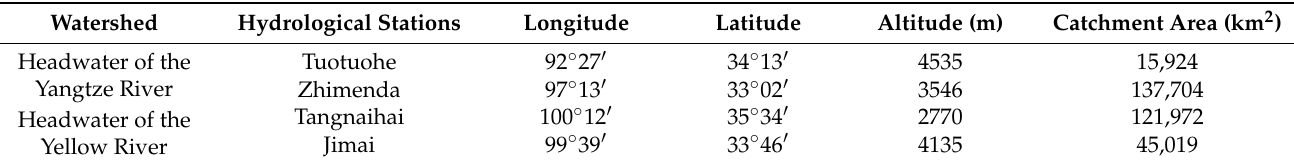
Table 1. Basic information of 4 hydrological stations in